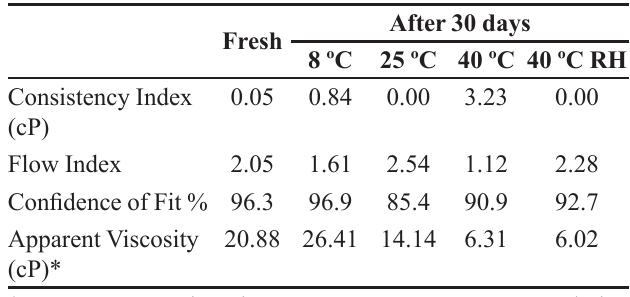
TABLE V - Results of Rheological analysis of MeA fresh sample and samples stored in different conditions for 30 days